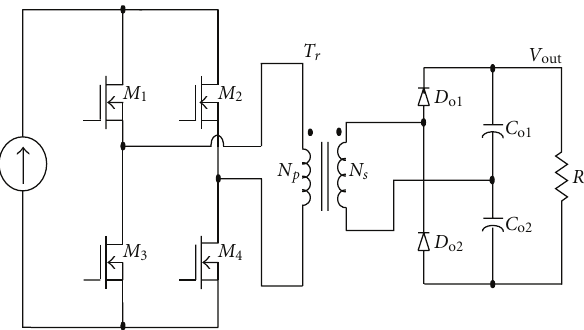
Figure 2: Simplified circuit diagram of the proposed PV power- generation